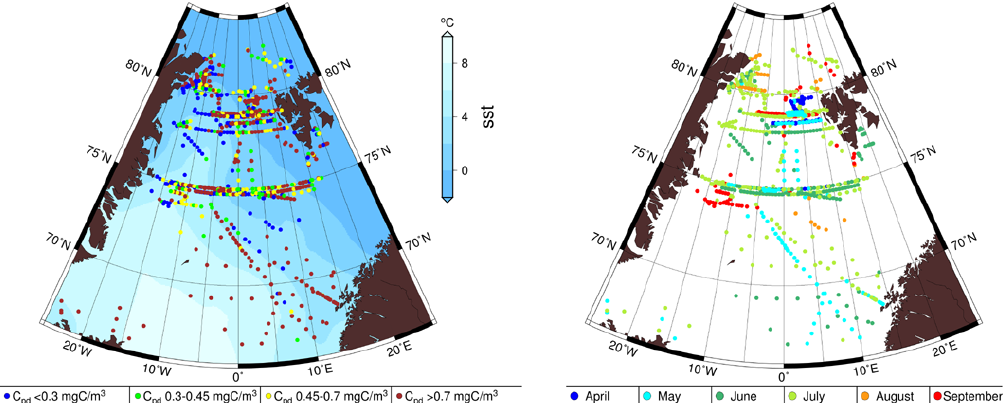
Fig. 3. Left: locations of CHL profiles, colour of the circle indicates the C pd category assigned. In the background is the sea surface temperature climatology map for 2002–2012 (data from Physical Sciences Division, Earth System Research Laboratory, NOAA, Boulder, Colorado, http://www.esrl.noaa.gov/psd/). Right: locations of CHL profiles, colour of the circle indicates the month of